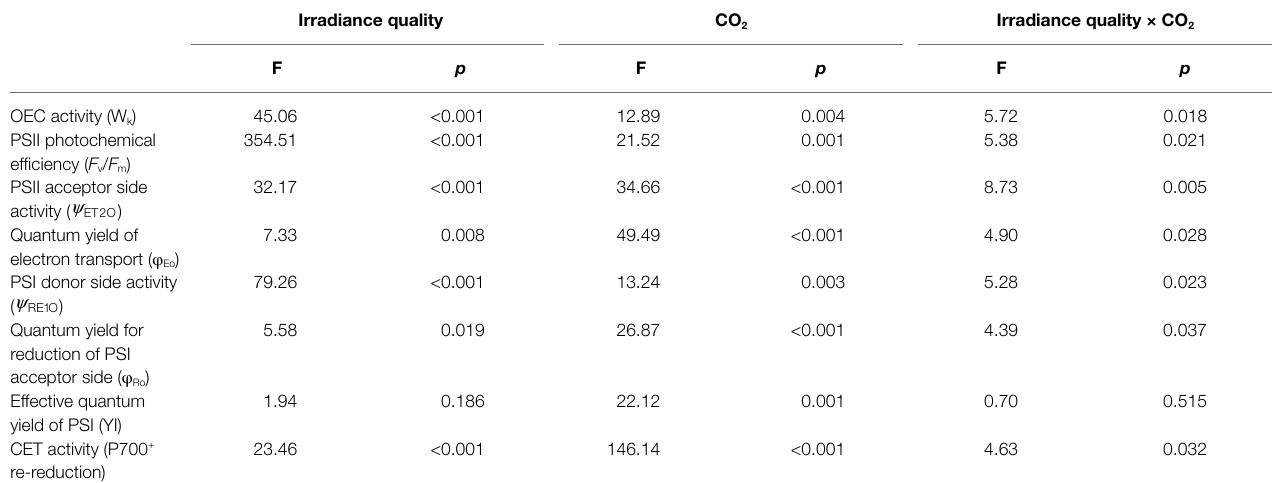
TABLE 2 | Two-way ANOVA for the effects of CO 2 (~400 and ~ 1,000 μ atm) and irradiance quality photosynthetically active radiation (PAR, PAR + UVA and PAR + UVA + UVB) on the OEC activity (W k ), photosystem II (PSII) photochemical efficiency ( F v / F m ), intersystem electron transport efficiencies ( ET2O